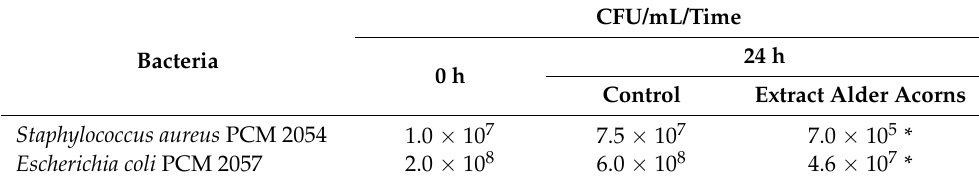
Table 5. Effect of water extract of Alder acorns on bacteria number. Bacteria